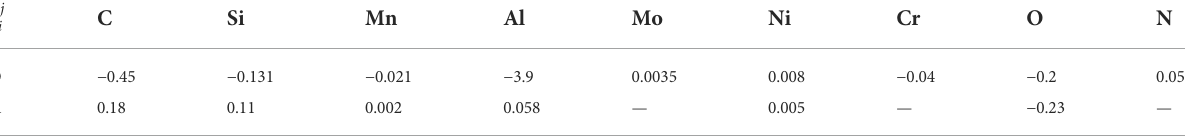
TABLE 2 Interaction coef fi cients used in the present study.